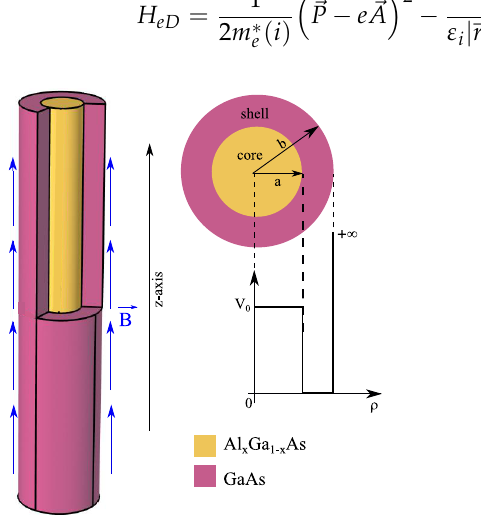
Figure 1. Schematic illustration of the cylindrical core/shell nanowire and the corresponding con- duction band structure. The core is taken to be Al x Ga 1 − x As material with controllable radius a , surrounded by GaAs material-based shell with radius b . we assume that the structure is under the effect of an external magnetic field (cid:126) B along the z